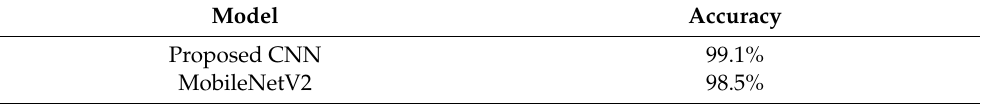
Table 7. Accuracy metric value for the proposed CNN model and MobileNetV2 model.